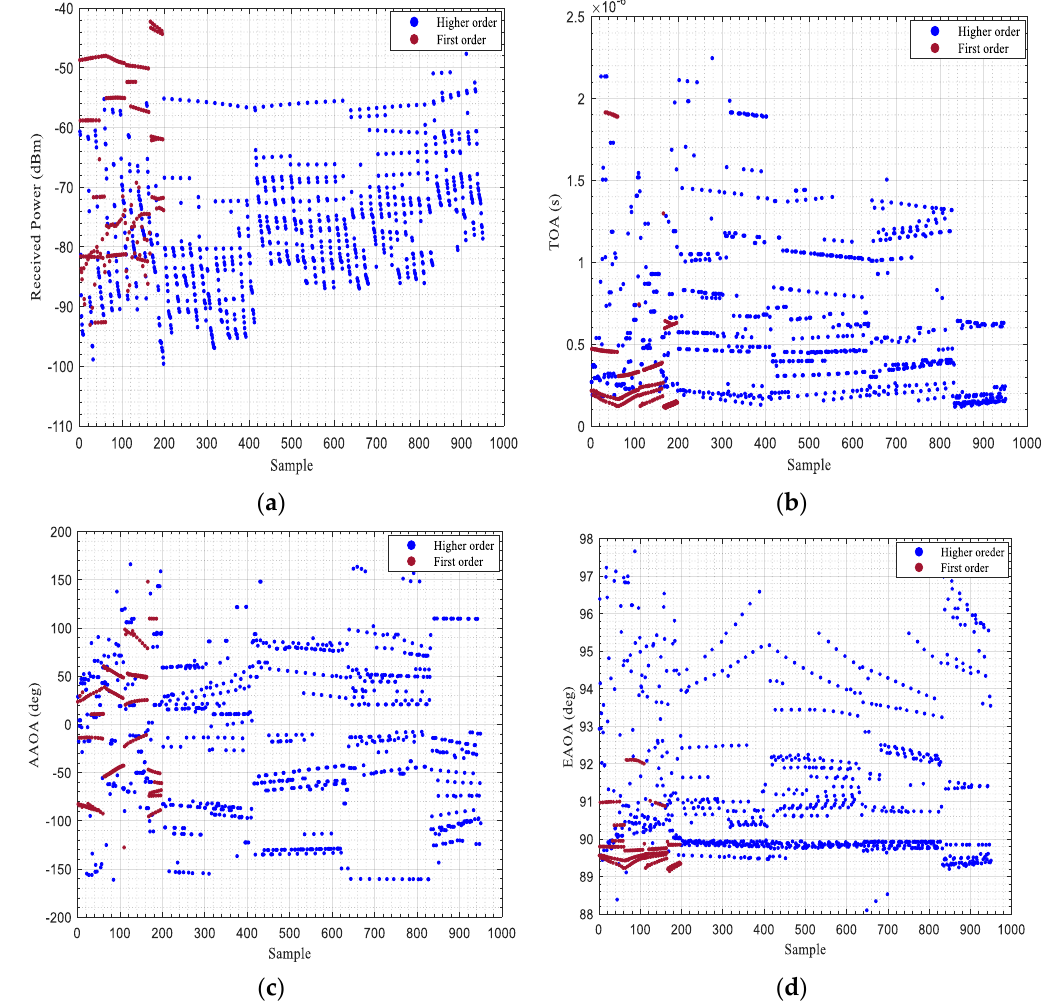
Figure 6. Distribution of the factors in the FOMPs and HOMPs ( a ) Received power, ( b ) TOA, ( c ) AAOA, and ( d ) EAOA.